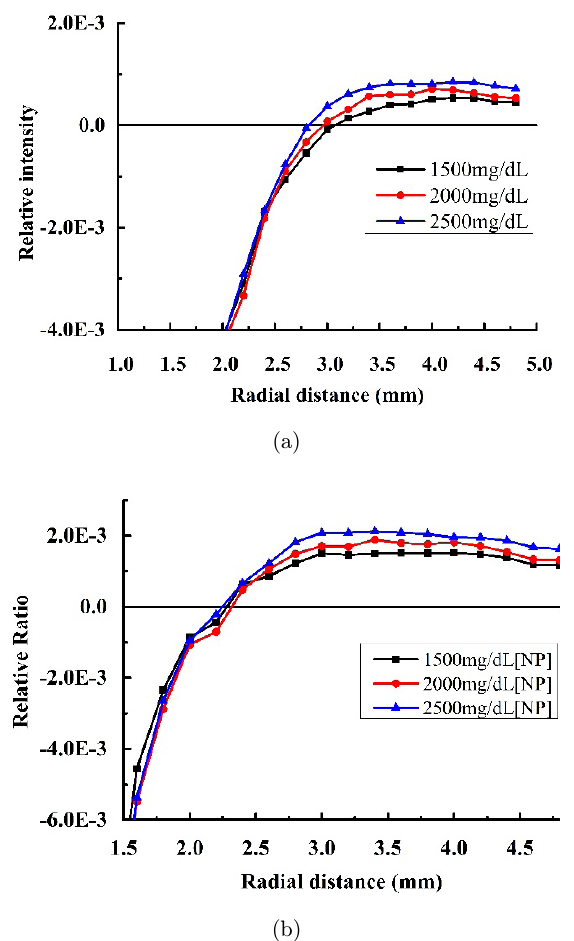
Fig. 10. The FRPs by experiment: (a) without NP model and (b) with NP model.